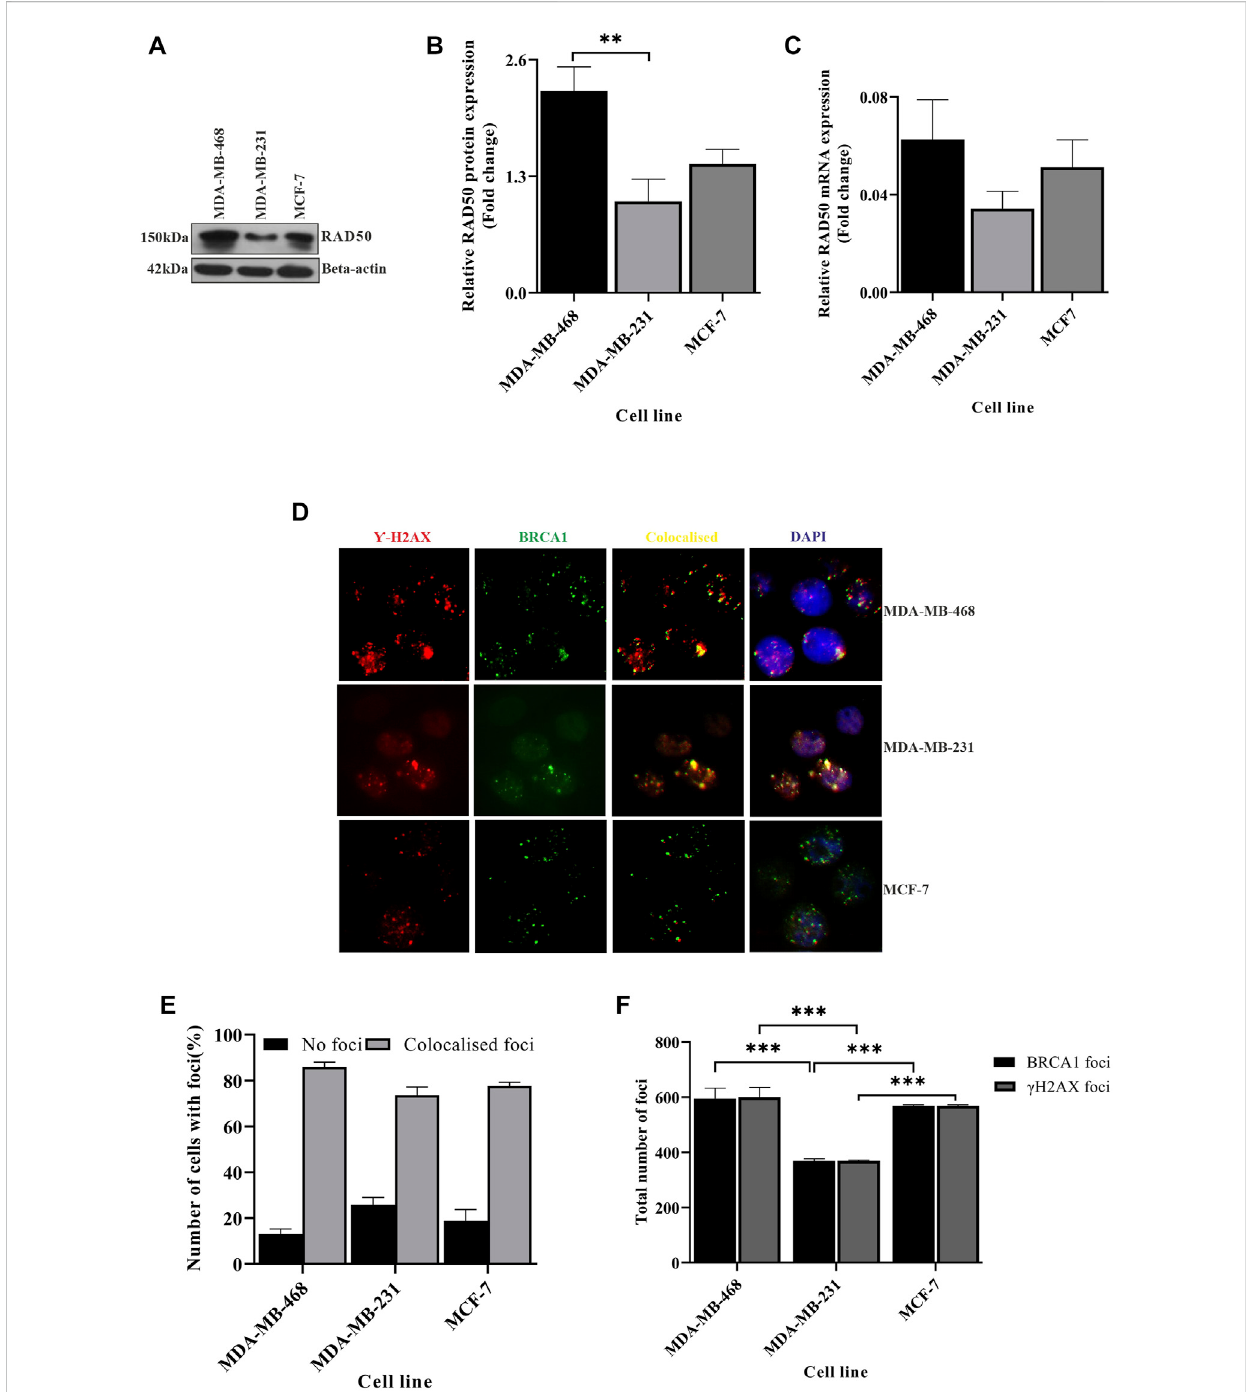
FIGURE 3 DNA damage sensing abilities changes between different TNBC lines. (A) Rad50 expression is compromised in MDA-MB-231 cells: RAD50 expression was detected by western blot analysis of proteins extracted from breast cancer lines, TNBC subtypes MDA-MB-468 and MDA-MB- 231 and luminal type cell line MCF-7, using antibodies directed against Rad50 protein. β -Actin is considered as the loading control. (B) Quanti fi cation of RAD50proteinexpressioninallthecelltypes:theintensityoftheRAD50bandsfromthewesternblotanalysiswasquanti fi edusingImageJsoftware. The values of band intensities were normalized with corresponding intensities of β -actin. (C) MDA-MB-231 cells showed compromised expression of RAD50 transcript also: expression studies were performed with cDNA (500 ng of RNA) from the aforementioned cell lines. The RAD50 expression was quanti fi edbyreal-timePCRfromthetechnicaltriplicatesandrepresentedinthebargraph. ΔΔ CtvaluewascalculatedfromtheC t valueofGAPDHandNo templatecontrol(NTC). (D) FormationoflessH2AXfociinMDA-MB-231:representative fi eldsofimmuno fl uorescenceassayshowinggamma-H2AXand BRCA1 foci. The reddots inthe fi rst panel indicate thegamma-H2AX foci, green dots inthesecond panel indicate theBRCA1 foci, yellowdots inthe third panel indicate the co-localized foci, and blue dots in the fourth panel show the co-localization of H2AX-BRCA1 foci with the nucleus (DAPI). (E) The colocalization of BRCA1 with H2AX is mildly compromised in MDA-MB-231: the percentage of cells with no foci and co-localized foci was analyzed by counting 200 cells and is represented in the bar graph. (F) H2AX-BRCA1 foci as the marker for DNA damage sensing are signi fi cantly compromised in MDA-MB-231: the foci formation is analyzed manually by scoring the red and green dots in 200 cells. MDA-MB-231 with less H2AX BRCA1 foci con fi rms the defect in damage sensing. All the experiments in this fi gure were performed in biological triplicates. Data were analyzed by one-way and two-way ANOVA (SEM is shown as an error bar. * p < 0.05, ** p < 0.005, and *** p <